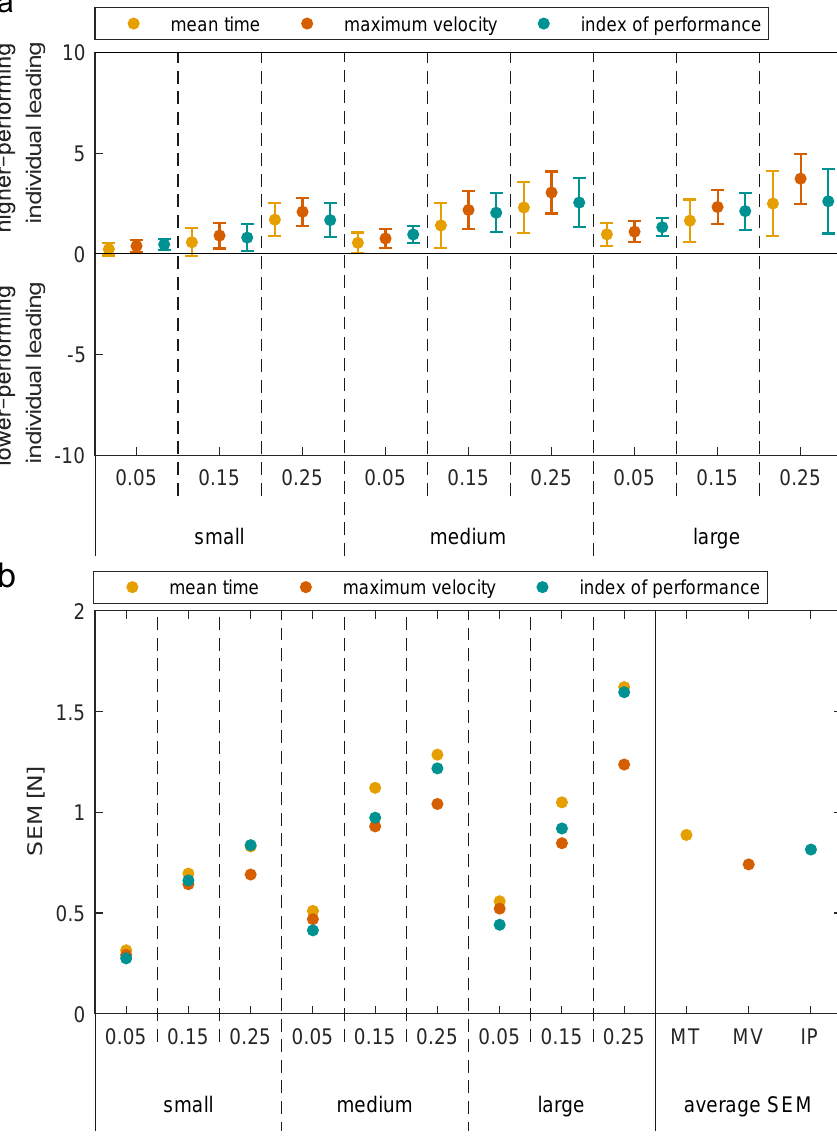
Figure 3. ( a ) Leading subject for all targets based on each sorting method, where the values represent mean leader L [ N ] between the 8 pairs ± SEM. The bottom plot ( b ) shows comparison between SEM of each sorting method for individual